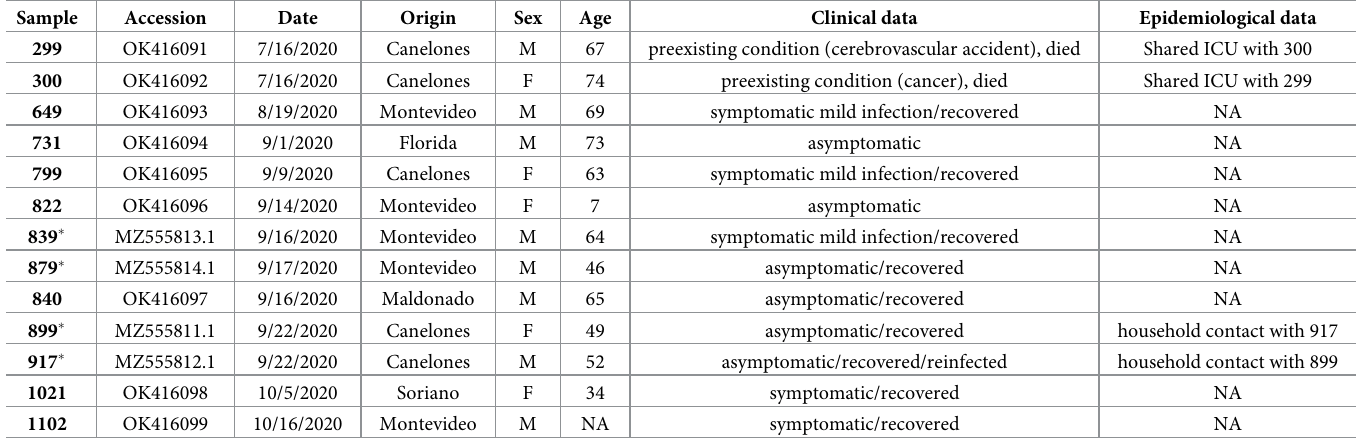
Table 1. Epidemiological data of the samples analyzed in the